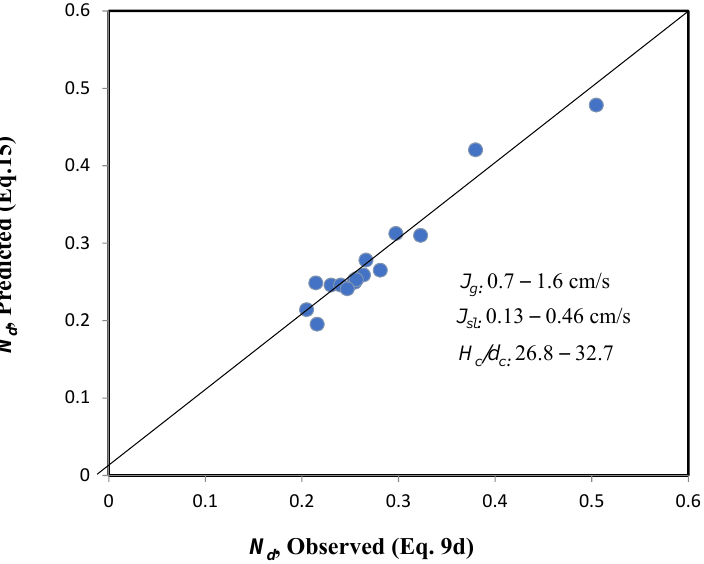
Figure 6. Relationship between calculated and observed vessel dispersion number, N d .